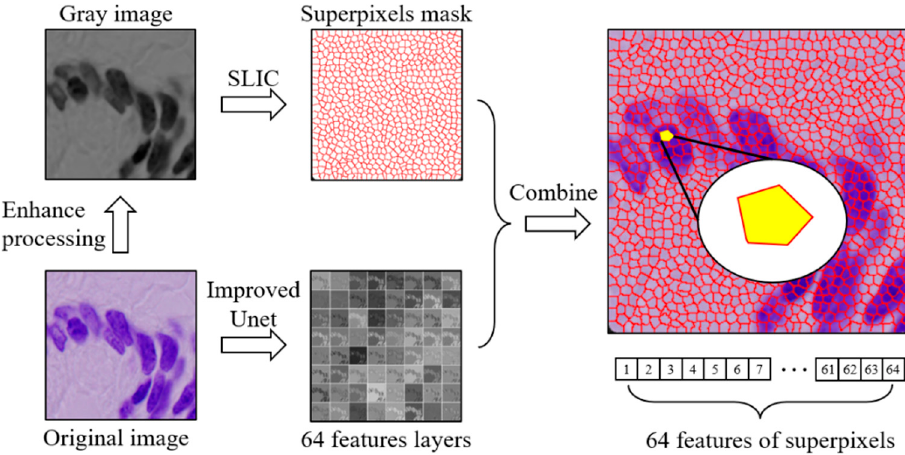
Figure 5. Superpixel feature dataset with the improved Unet model and SLIC algorithm.